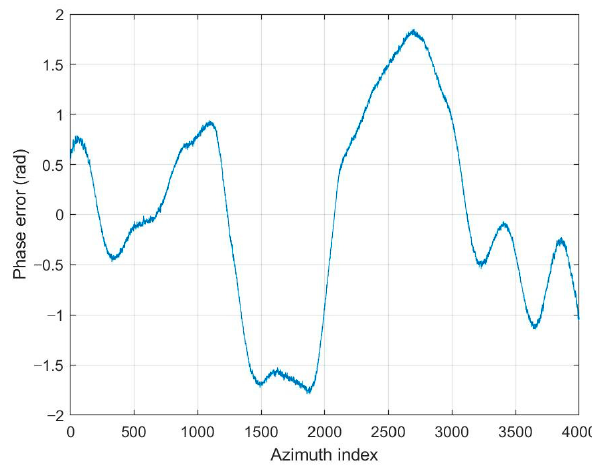
Figure 3. Phase error applied to the SAR image in Figure 2c.